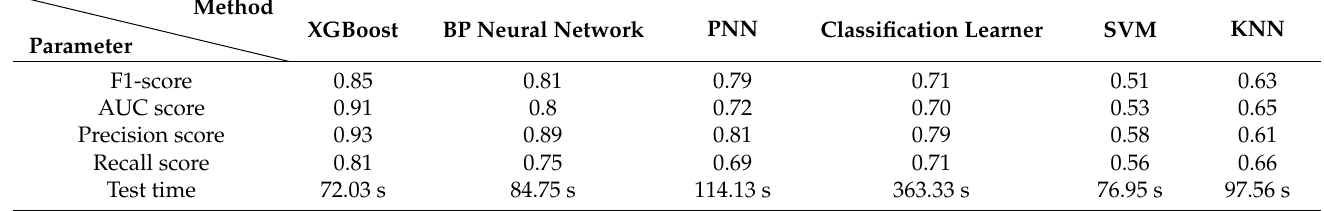
Table 6. Comparison of results of six